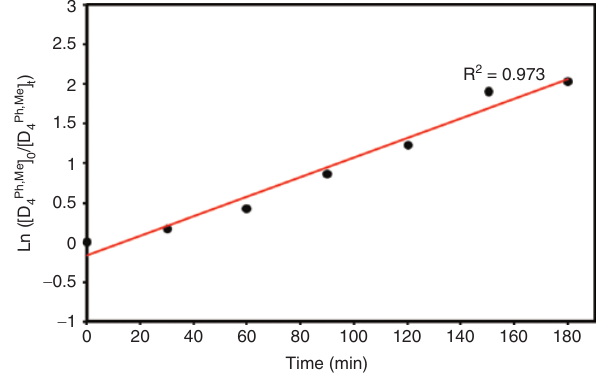
/[D 4Ph,Me ] ), where D 4Ph,Me 0 t